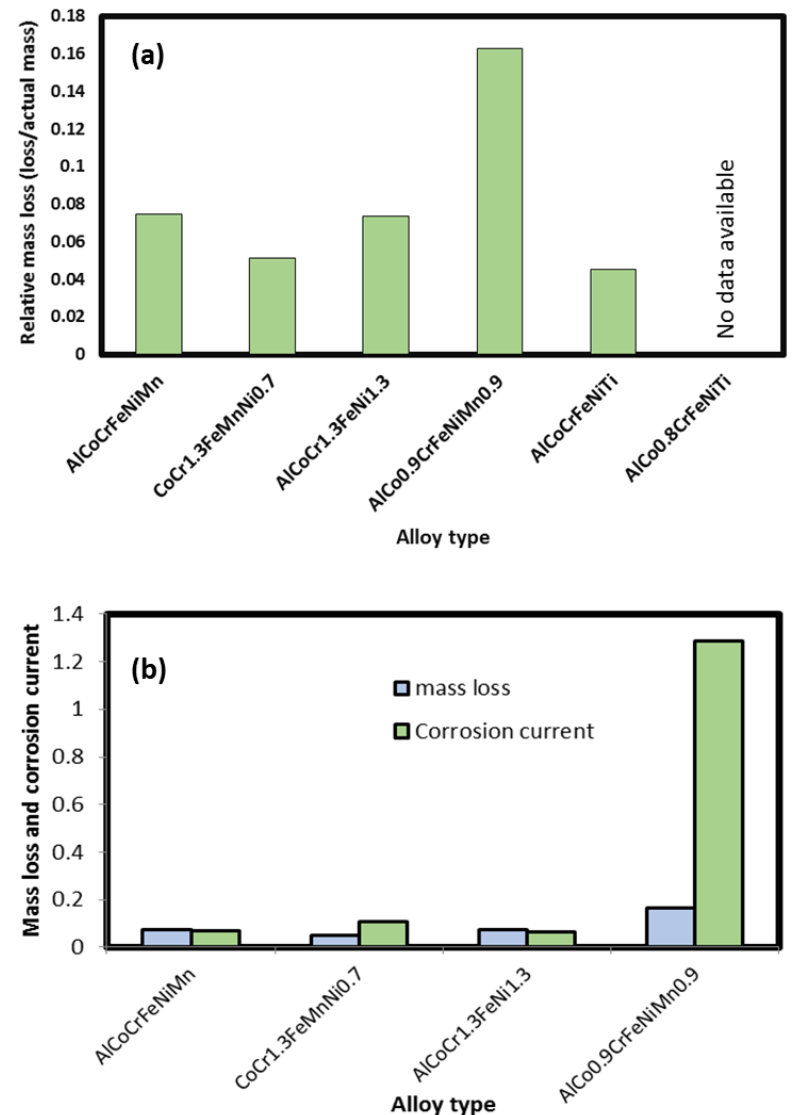
Figure A13. ( a ) Accelerated corrosion Mass loss test results for different HEAs. ( b ) The comparison of mass loss tests and corrosion current (as noted in potentiodynamic scans) for different HEAs.